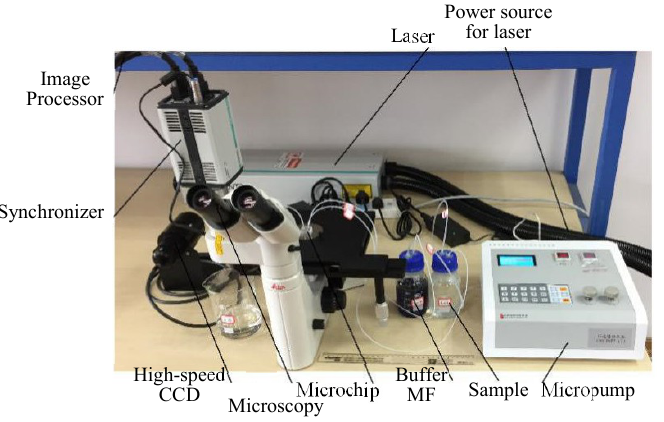
Figure 11. Experimental setup for laser-induced fluorescence.